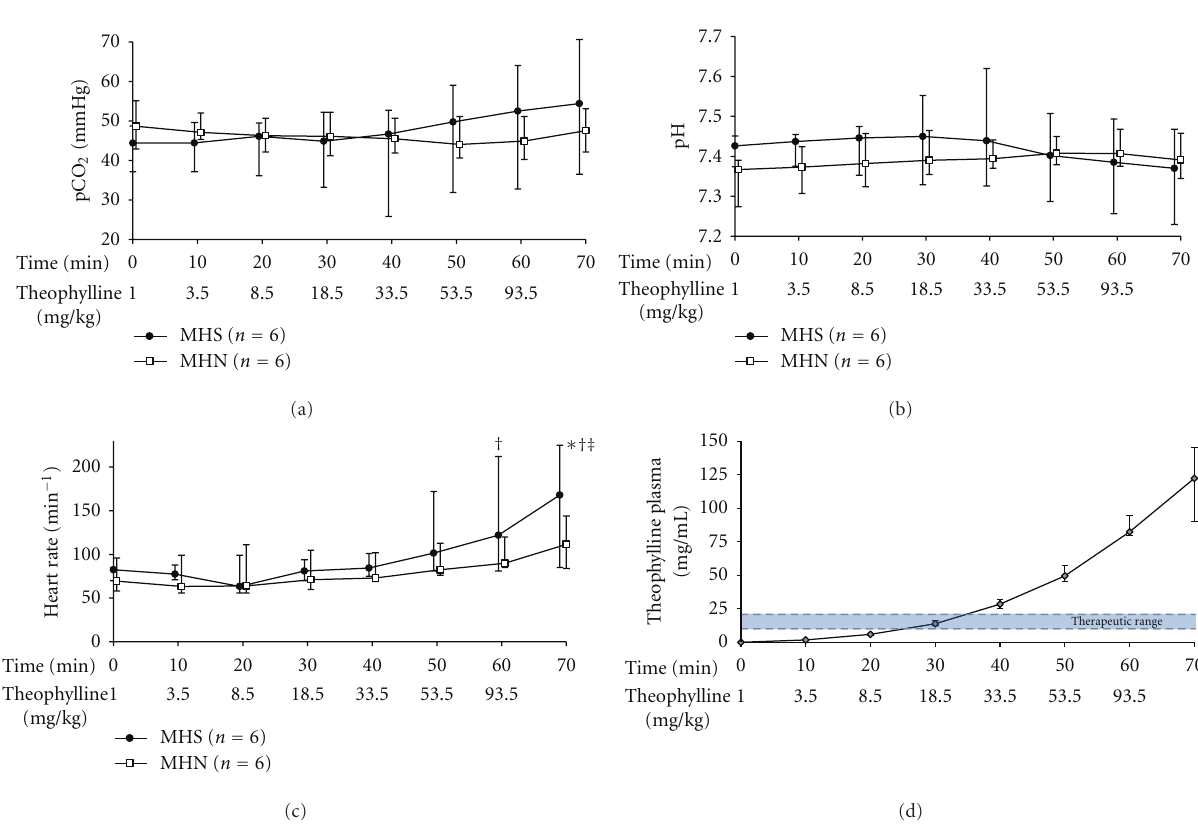
Figure 1: Central-venous pCO 2 (a), central-venous pH (b), heart rate (c), and plasma theophylline concentration (d) following cumulative intravenous administration of theophylline in malignant hyperthermia-susceptible (MHS) and normal (MHN) swine. Shown are median ± range. ∗ P < 0 . 05 MHS versus MHN; † P < 0 . 05 MHS versus 0 minutes; ‡ P < 0 . 05 MHN versus 0